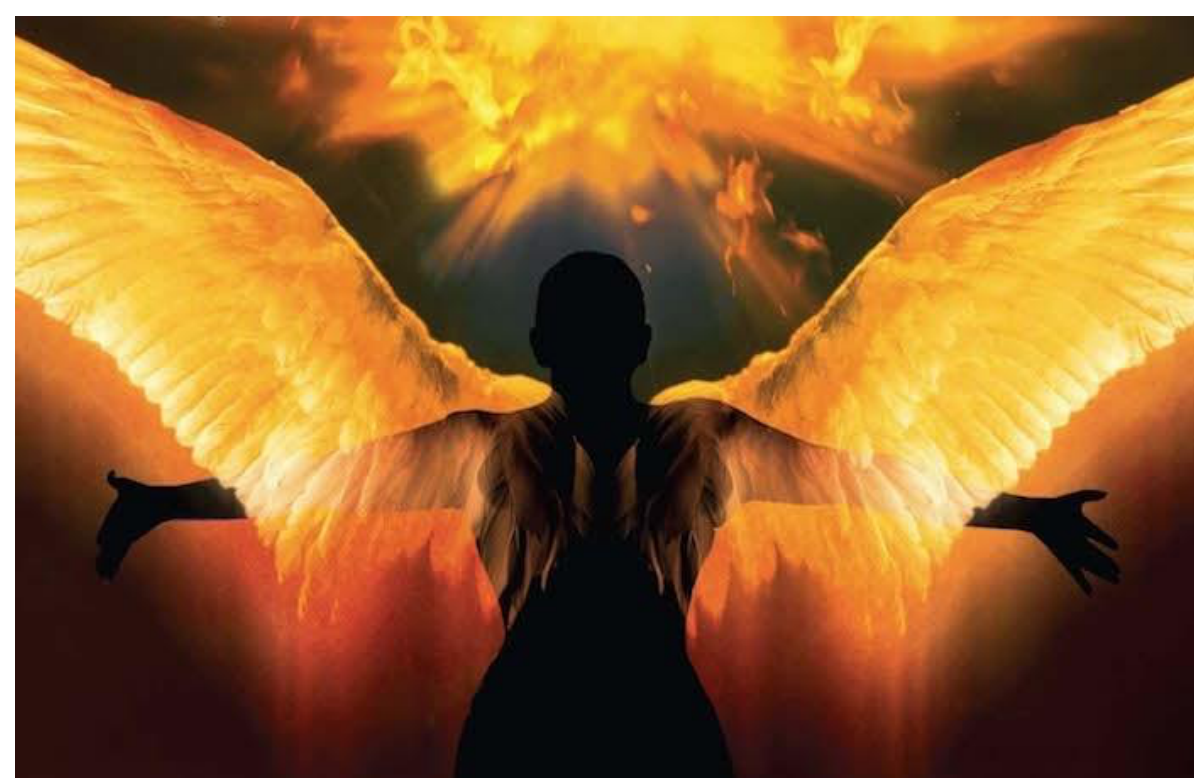
COVER ART FIGURE BY ELIZA LAZO FOR ARCANGEL IMAGES. ART BURNING FIELD BY HARALD SUND FOR GETTY